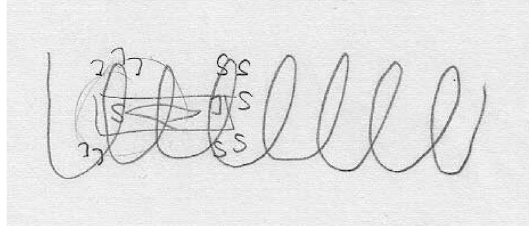
FIG. 8. Faith_4 ’ s graphical representation of the magnetic field inside the coil indicating local reasoning. Note that the abbrevia- tions are J for south ( “ jug ” in Croatian) and S for north ( “ sjever ” in